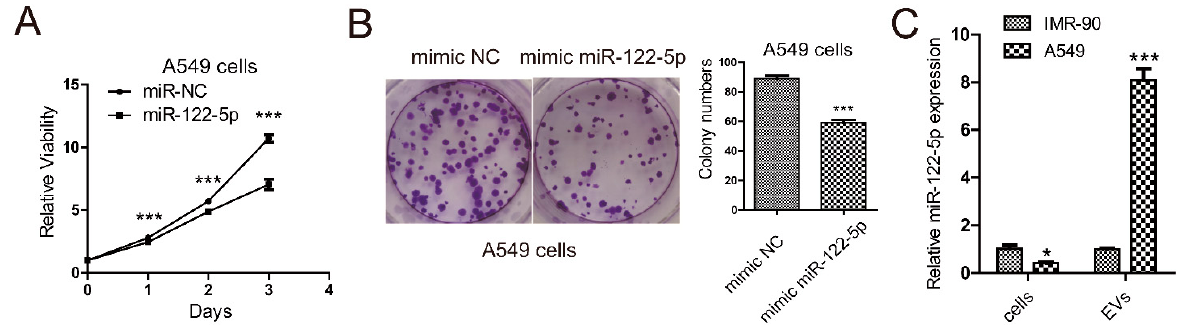
Figure 1. miR-122 is a suppressor of lung cancer A549 cells and is highly enriched in the A549 EVs. ( A ) MTT assay shows the proliferation ability of A549 cells overexpressing miR-122-5p mimic or NC mimic. ( B ) Colony formation assay of A549 cells transfected with constructs expressing miR-122-5p mimic or NC mimic. In addition, the statistical results of colony numbers are shown in the right panel. ( C ) Expression of miR-122-5p in EVs and cell lysates from IMR-90 and A549 cells detected by qPCR. Three independent experiments were performed, and statistical analyses were performed with the Student’s t test. *: p < 0.05, ***: p < 0.001.